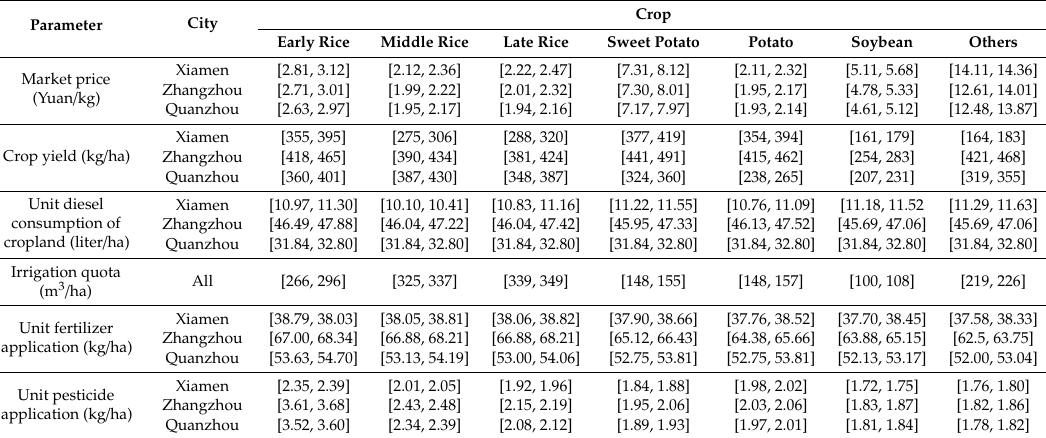
Table 1. Values of interval parameters.